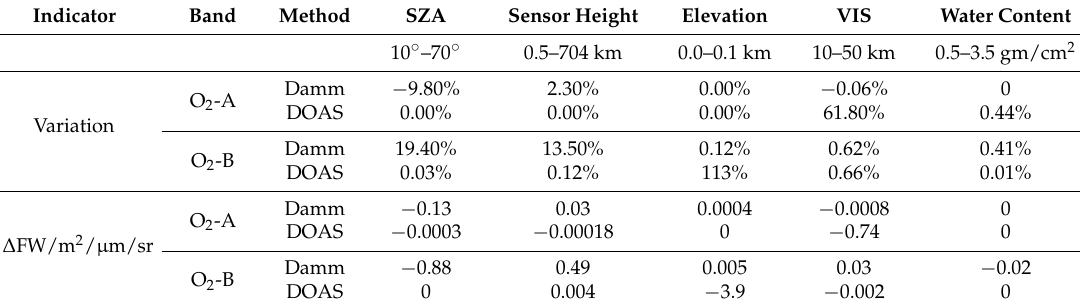
Table 7. Study of the sensitivities of different methods to atmospheric parameters. The variation is the observed maximum fluorescence variation, and it is calculated as the variation value divided by the base value. ∆ F is the max value of variation in fluorescence. The reference configuration is